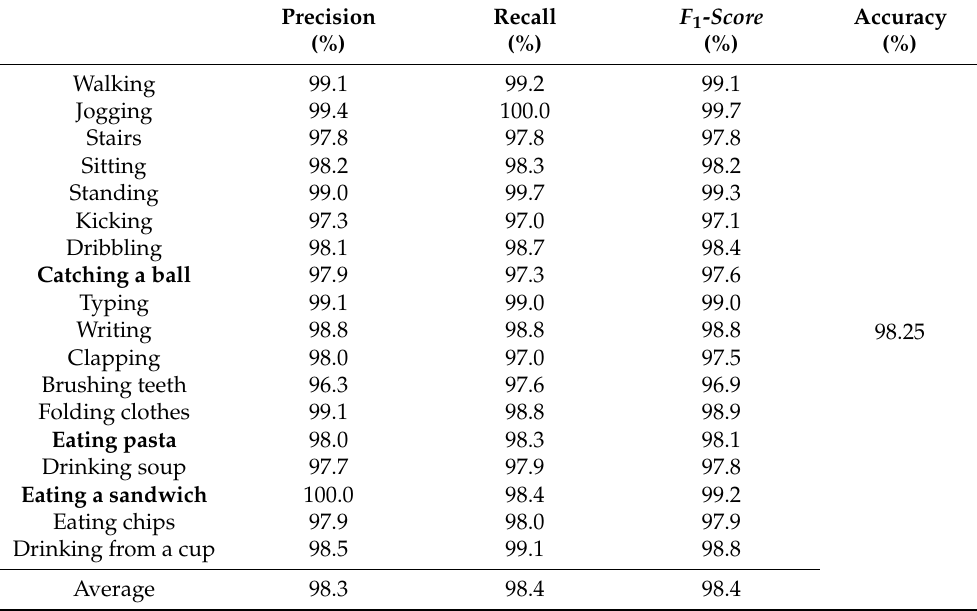
Table 7. The performances of the SLFN with the RELM algorithm for 18 types of physical activities. Precision